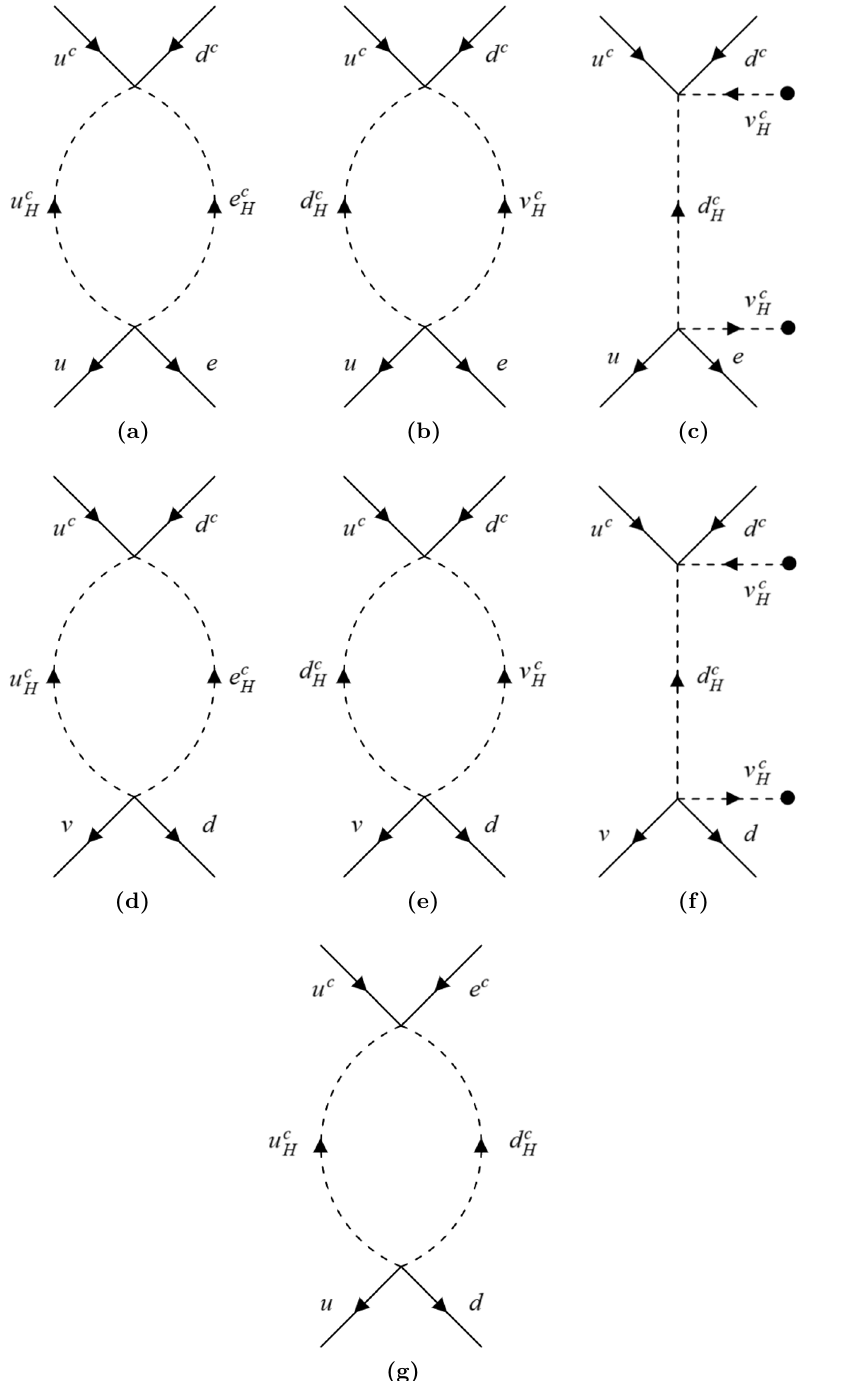
Figure 6. Dimension-six proton decay diagrams. Dashed lines represent bosons, solid lines repre- sent fermions, and dots represent the vevs. These are graphs between the B -violating superpotential coupling F c F c H c H c and the B -conserving superpotential coupling FFH c H c .